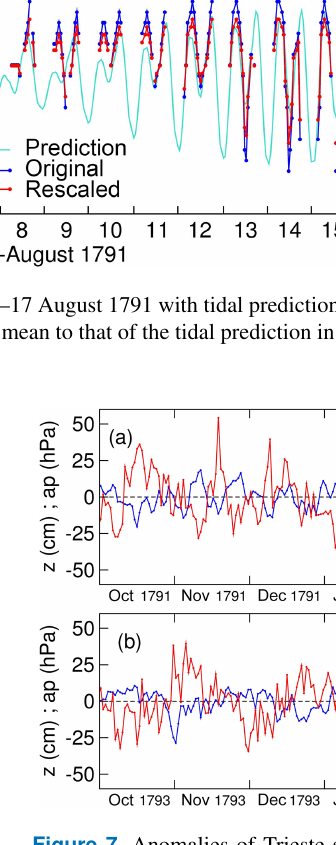
Figure 7. Anomalies of Trieste sea height ( z , red) and Padua at- mospheric pressure (ap, blue) in (a) October 1791–April 1792 and (b) October 1793–April